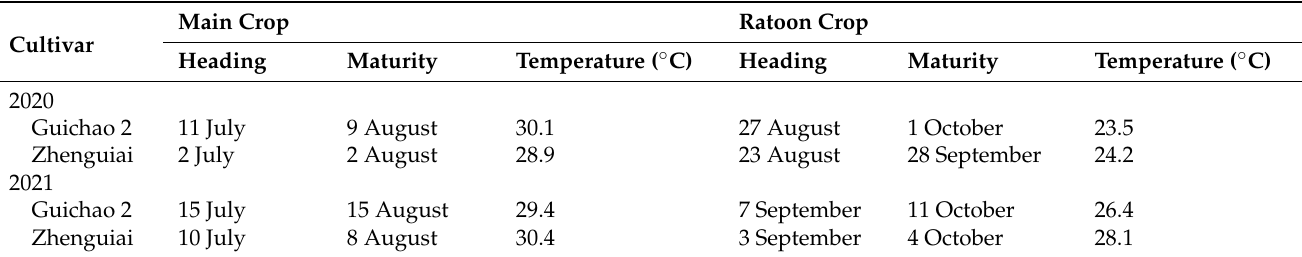
Table 1. Heading and maturity dates and daily mean temperature during the ripening period for main and ratoon crops of two cultivars, Guichao 2 and Zhenguiai, grown in 2020 and